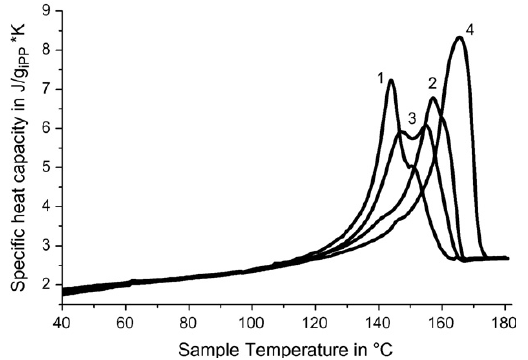
different ratios of ceramics:i-PP. Y pure i-PP (4)